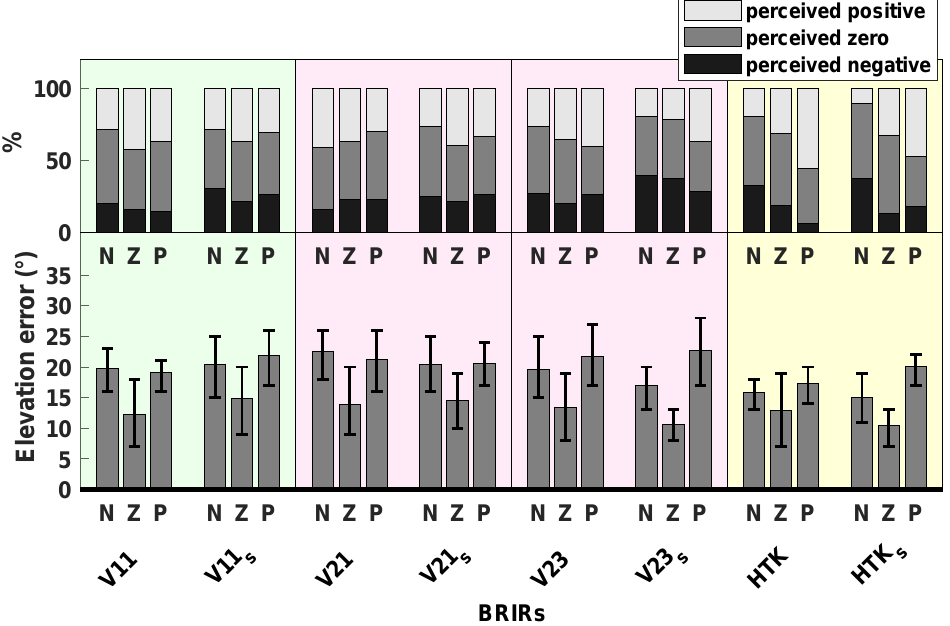
Figure 12. Average elevation error, when localizing virtual sources generated with V11, V21, V23 and HTK in TestDynamic and with V11 s , V21 s , V23 s and HTK s in TestStatic. ( Bottom ) Absolute error, averaged over 14 subjects for negative (N), zero (Z) and positive (P) target elevations. Error bars indicate 95% confidence intervals. ( Top ) Percentages of response elevations which were perceived as negative (below − 5 ◦ ), zero (between − 5 ◦ and + 5 ◦ ) or positive (above + 5 ◦ ). Externalization rate: To calculate the externalization rate as defined in Part I, the re- sponses given for the source distance were divided into two groups: “not externalized” (scores 0 and 1) and “externalized” (scores 2 and 3). Figure 13 shows the externalization rate over the target